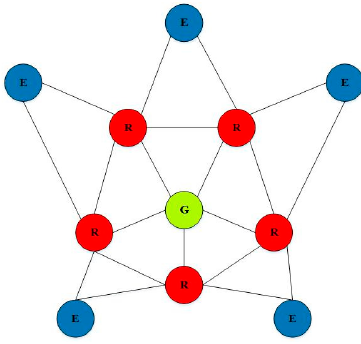
Figure 5. The structure of a mesh star composite topology in which nodes are connected to a central node [24].